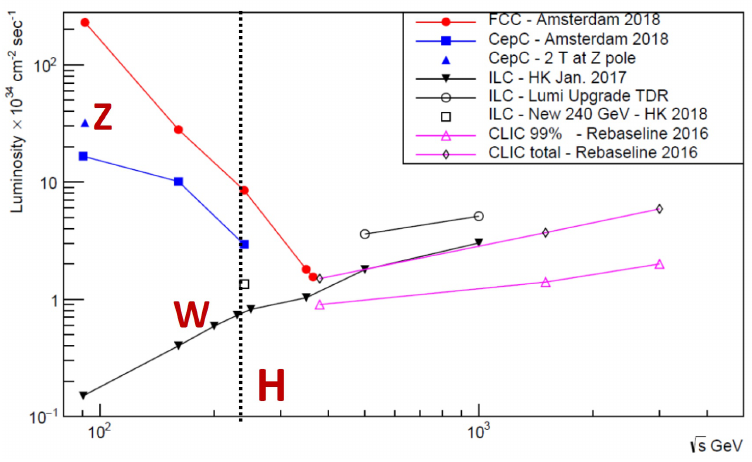
Figure 3. The luminosities vs the CM energies (cf. [8]) for all four projects of electron-positron colliders discussed in the